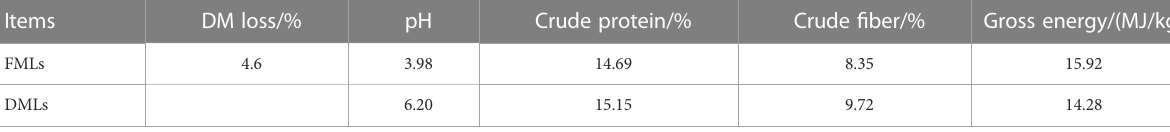
TABLE 1 Chemical composition of FMLs and DMLs.